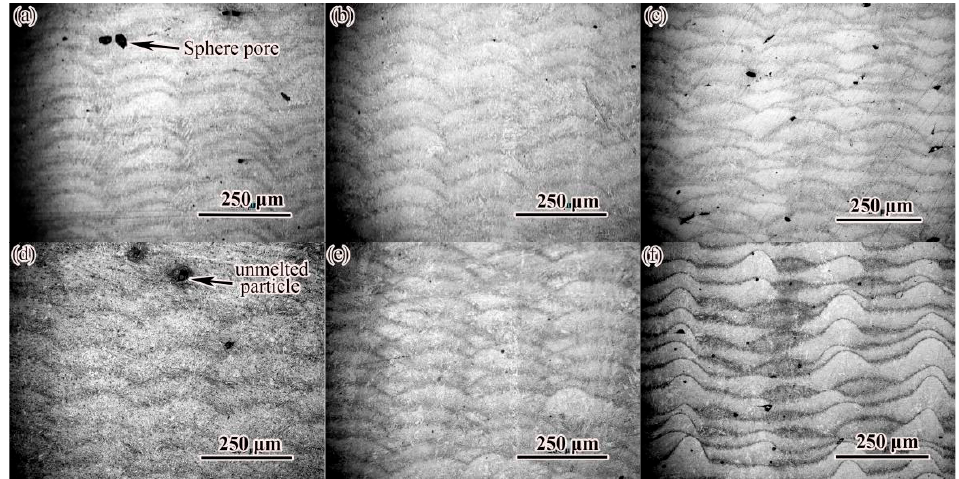
Figure 5. OM image of cross section of alloy steel formed by SLM at different scanning speeds: ( a ) V = 500 mm/s; ( b ) V = 600 mm/s; ( c ) V = 700 mm/s; ( d ) V = 800 mm/s;( e ) V = 900 mm/s; ( f ) V = 1000 mm/s.